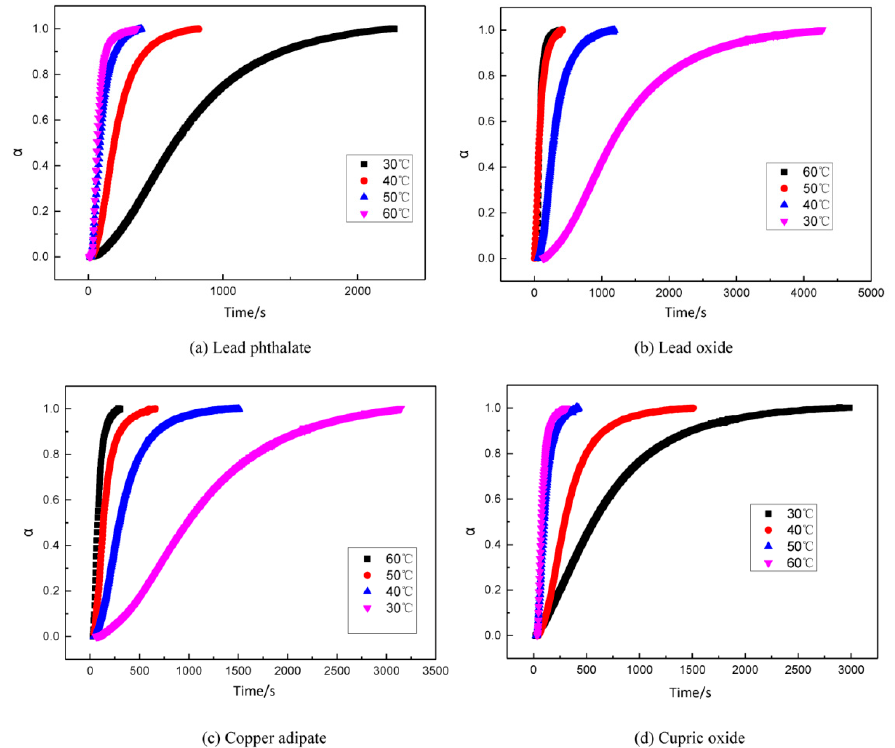
Figure 7. The change curve of storage modulus of the GAPSPs with time.